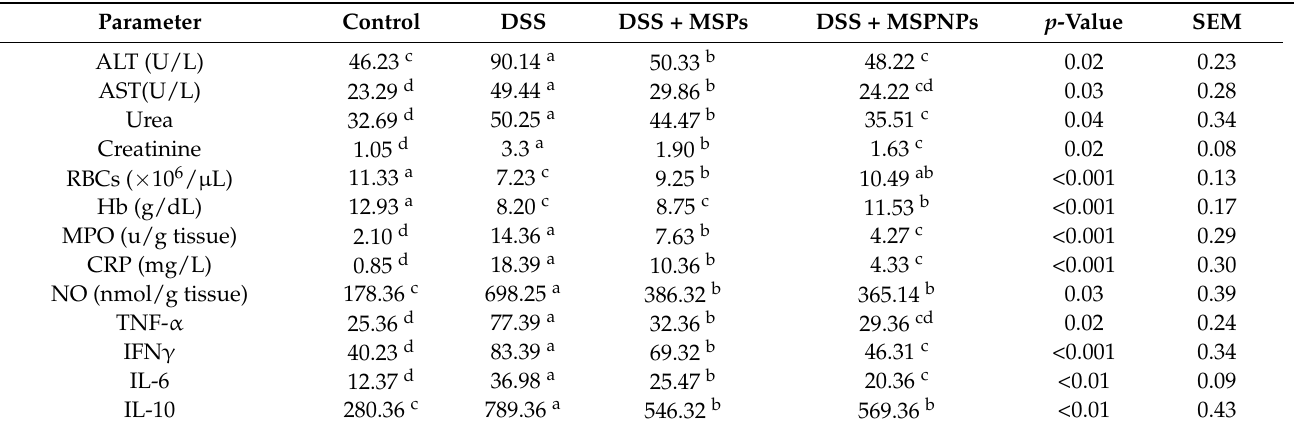
Figure 2. Impacts of orally administered free multi-strain probiotics (MSPs) or multi-strain-probiotic-loaded nanoparticles (MSPNPs) on progression of colitic signs. ( a ) Body weight gain. ( b ) Disease activity index score. ( c ) Colon length. ( d ) Spleen weight. Non-colitic group: Control (rats were orally gavaged with PBS). Colitic groups including: DSS (rats were orally gavaged with dextrane sodium sulphate), DSS + MSPs (rats were orally gavaged with DSS and multi-strain probiotics (MSPs) at the level of 1.0 × 10 10 CFU/kg in 1 mL of PBS/rat/day for 14 days) and DSS + MSPNPs (rats were orally gavaged with DSS and multi-strain-probiotic-loaded nanoparticles (MSPNPs) at the level of 1.0 × 10 10 CFU/kg in 1 mL of PBS/rat/day for 14 days); all groups were orally gavaged with 5% DSS. Values are expressed as mean ± SE, a,b,c,d Means of the bars with different letters were sig- nificantly different among groups ( p < 0.05). Table 4. Liver and kidney function tests and hematological indices of colitic rats orally administrated free or multi-strain-probiotic-loaded nanoparticles